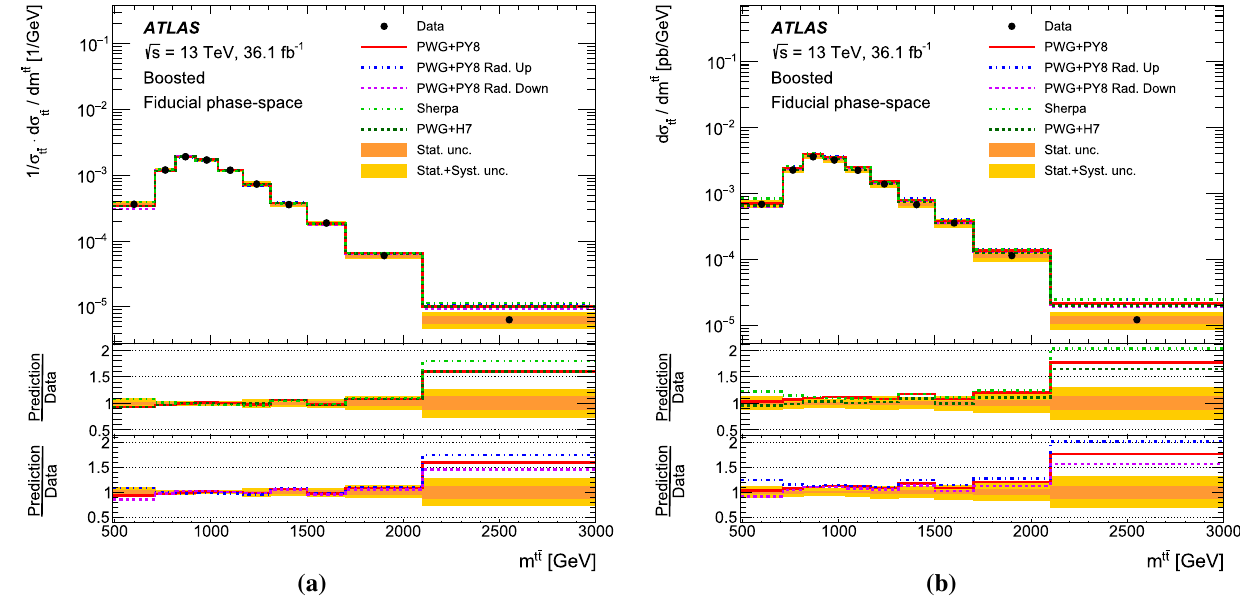
Fig. 40 Particle-level a normalised and b absolute differential cross- sections as a function of m t ¯ t in the boosted topology, compared with different Monte Carlo predictions. The bands represent the statistical